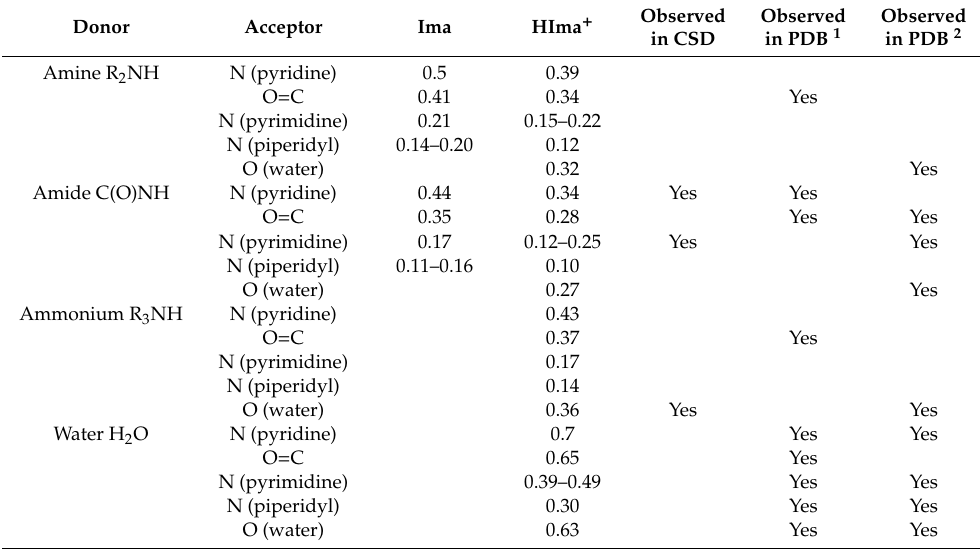
Table 2. Propensities of H-bonding in Ima and HIma +